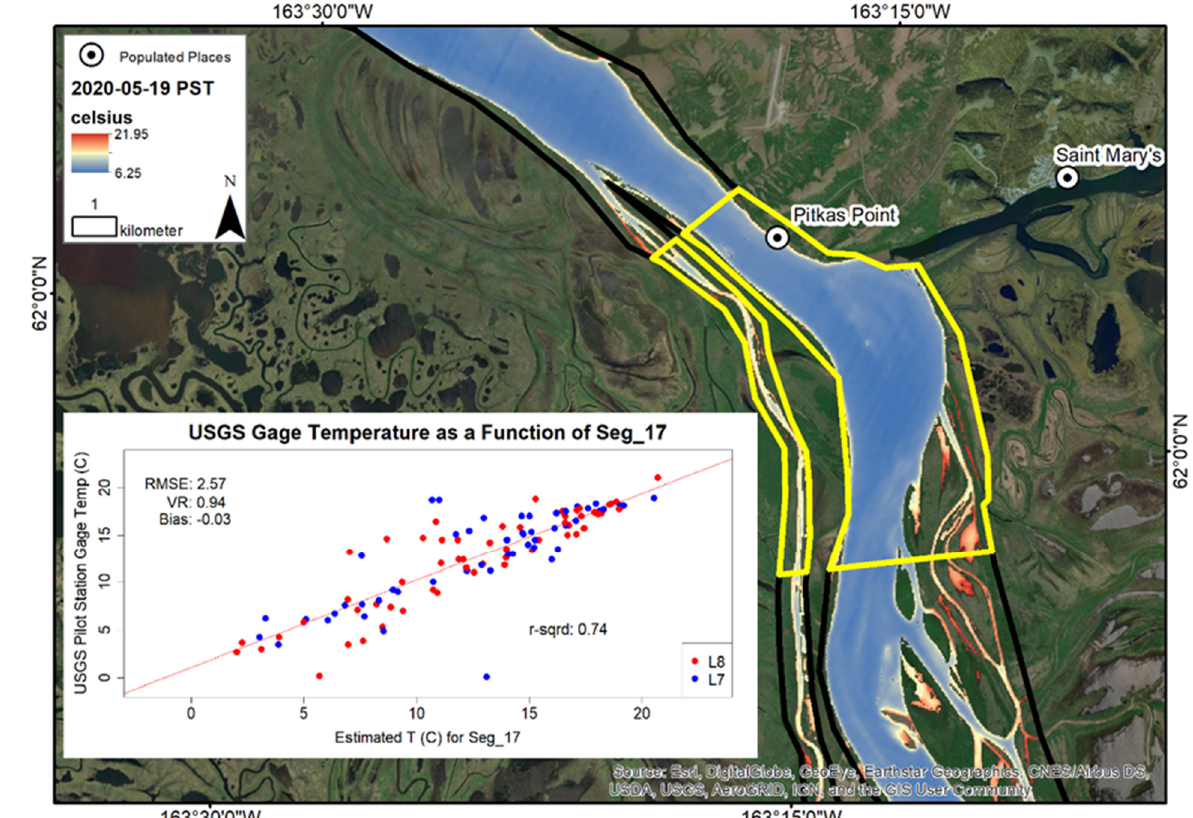
Figure A15. The river is contained to a single large channel and a meandering slough within segment 17. The river flows north leaving Goose Island, and then it bends slightly to the northwest after encountering another terminal extension of the Andreafsky Mountains. This is also where the Andreafsky River joins the Yukon River. The pST coverage is good with no NoData gaps. Correlations between water temperature datasets are good (RMSE = 2.57 °C, r 2 = 0.73).